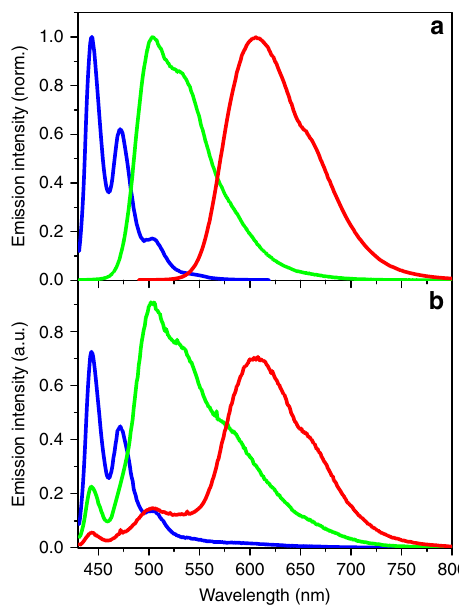
Fig. 3 Emission spectra in the polymer micelles. a Normalized emission spectra of per (blue line), DAEg(c) (green line), and DAEr(c) (red line) in the polymer micelles. b Emission spectra of the tri-component micelle cocktail before UV irradiation (blue line), after exposure to 242 nm light (4 nm spectral bandwidth, 10 min irradiation time, green line) and after exposure to 415 nm light (4 nm spectral bandwidth, 2.5 h exposure time, red line). All spectra in panel ( b ) were recorded upon excitation at 423 nm. The relative emission intensities determined by spectral integration in ( b ) are 1.3:4.4:3.7 (blue:green:red), that is, the system displays fairly small intensity variations accompanying the emission color